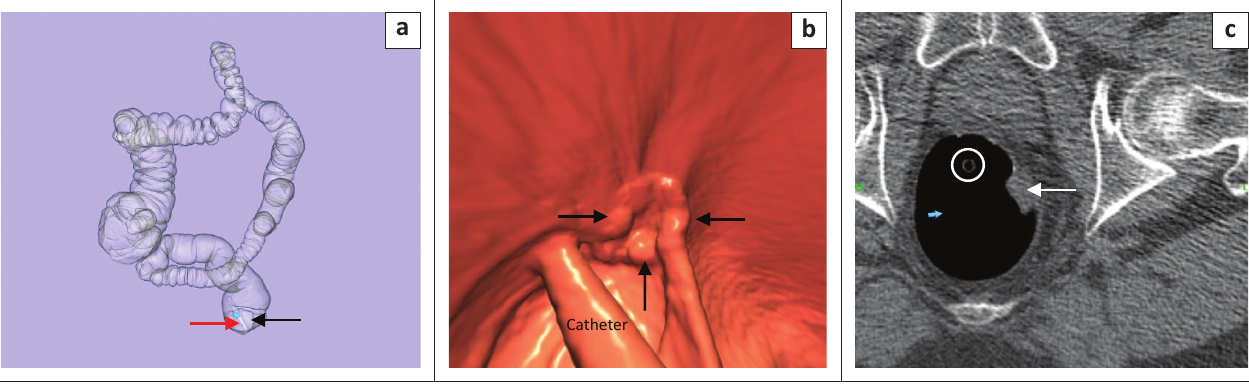
FIGURE 17: (a) Prone colon-map showing left rectal wall lesion (black arrow). Rectal catheter (red arrow); (b) 3D view of an irregular polypoidal lesion in rectum in keeping with cancer (black arrows); (c) 2D axial image shows catheter (white circle) and soft tissue mass with thickening of the left rectal wall in keeping with cancer (white